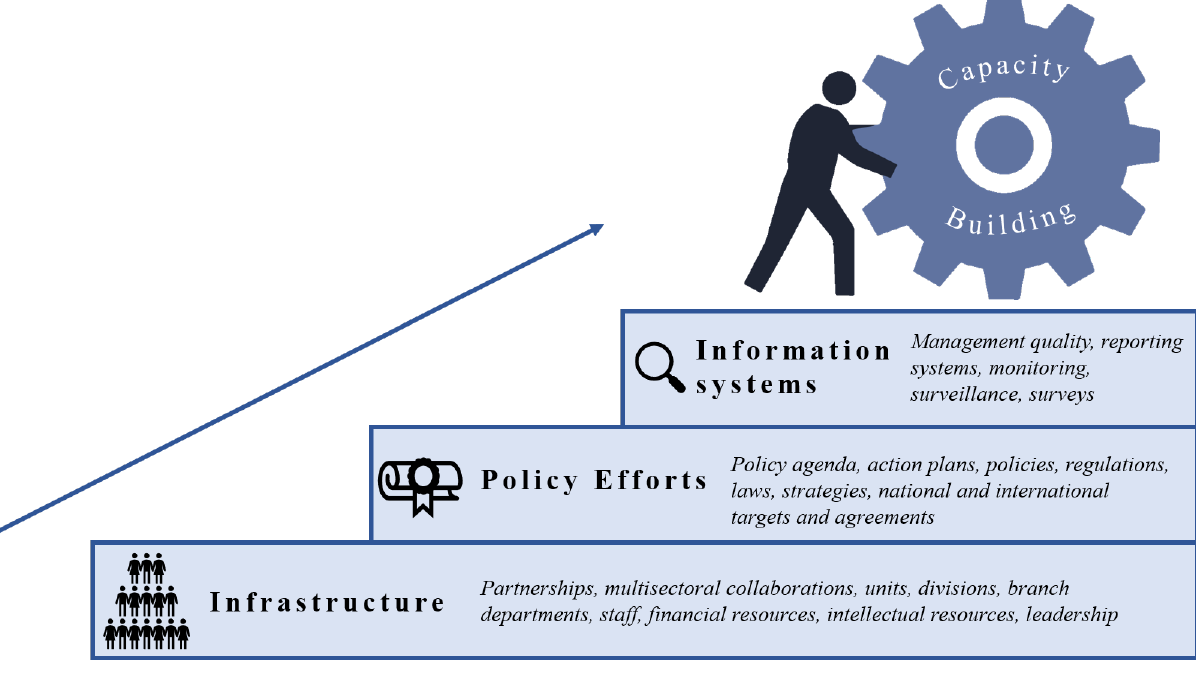
Figure 1. Government capacity-building framework. Adapted from World Health Organization, 2020 [24]; World Health Organization, 2006 [23]; Bergeron K, et al. BMC Public Health, 2017 [19]; Delisle H, et al. Bull WHO, 2017 [20].